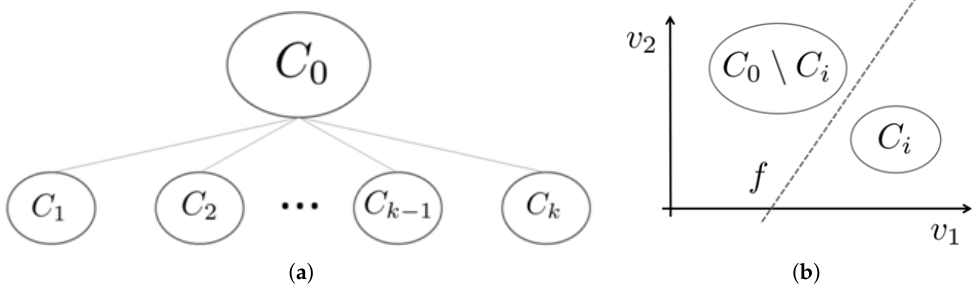
Figure 1. ( a ) Illustration of k clusters after the partitional clustering. ( b ) A representation of one- versus-all binary classification by means of a line segment f , where v 1 and v 2 are variables that enable the 2D